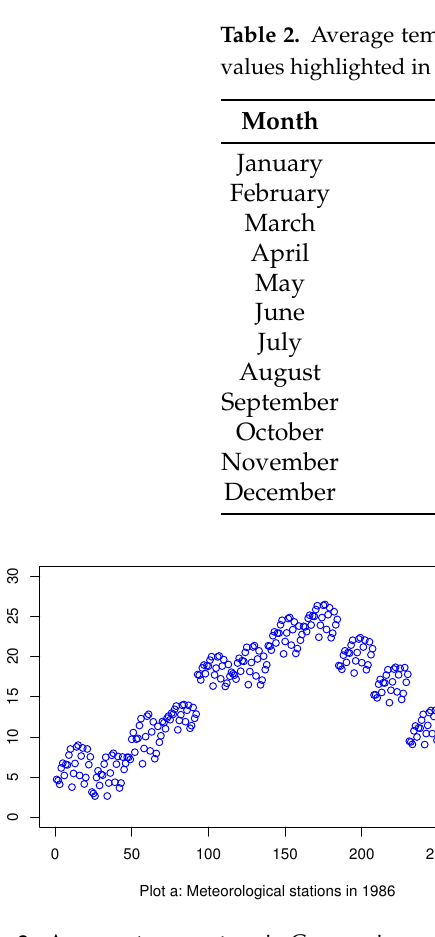
Figure 2. Average temperature in Campania over 12 months recorded in 23 meteorologic stations. Plot a: referred to the year 1986 and plot b to the year